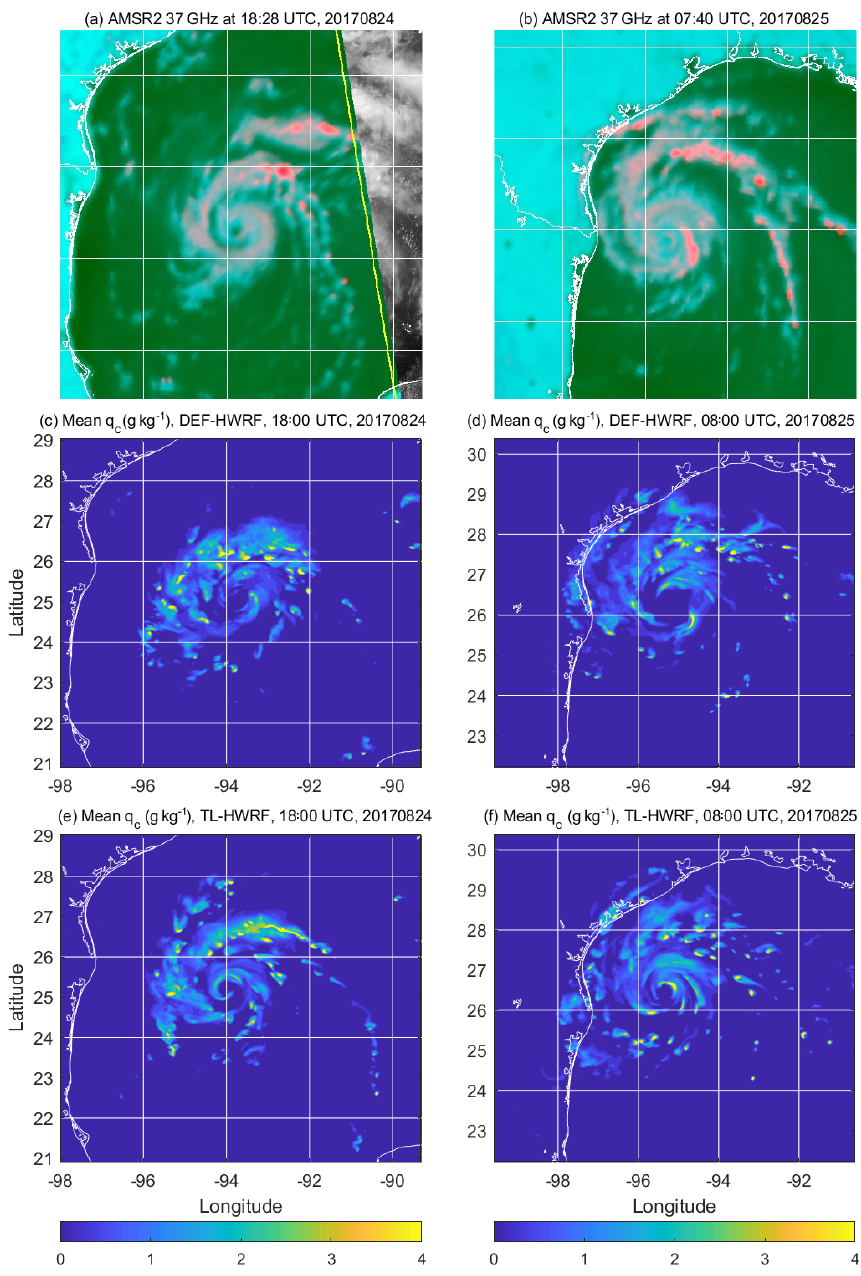
Figure 14. Comparison of vortex inner-core structure during the early stage (a, c, e) and middle stage (b, d, f) of the RI of Harvey (2017) between satellite (AMSR2) observations (a, b) at 18:28UTC, 24 August, and 07:40UTC, 25 August 2017, and HWRF simulations by DEF-HWRF (c, d) and TL-HWRF (e, f) at 18:00UTC, 24 August, and 08:00UTC, 25 August 2017. The shown simulated fields are the hydrometeor mixing ratio (gkg − 1 ) at 5.0km altitude. Note that the satellite images are from the Naval Research Laboratory 37GHz color product of AMSR2 (credit to NRL Satellite Team). The satellite images can be obtained at